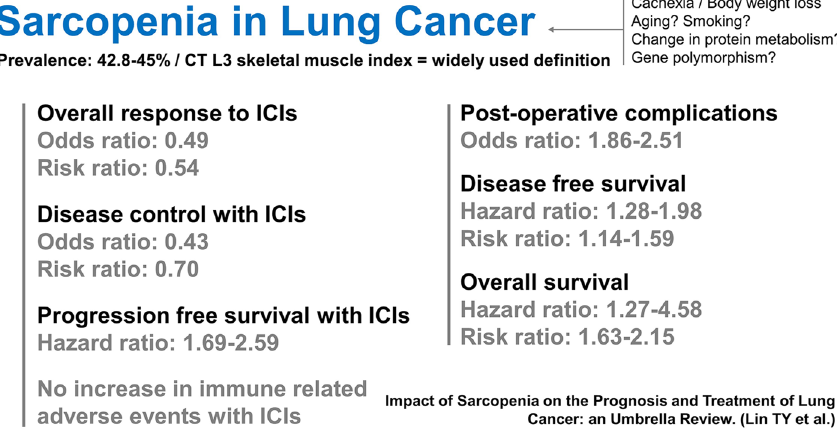
Fig. 2 Summary of the find- ings of this umbrella